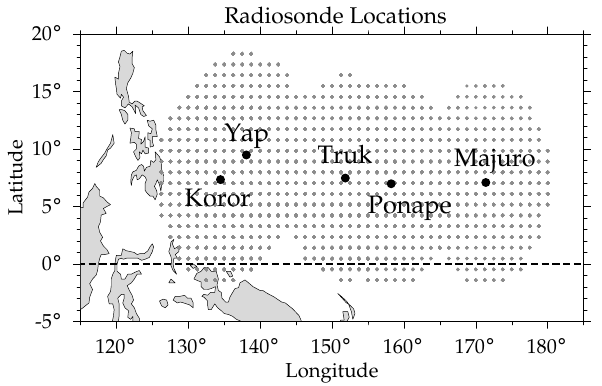
Fig. 1. A map showing the locations of the five radiosonde stations. The small gray dots refer to locations of the TRMM rain events used in the construction of the radial temperature anomaly profile shown in Fig. 2. Rain events within 1000km of multiple radiosonde stations were in general used multiple times in the construction of Fig. 2.